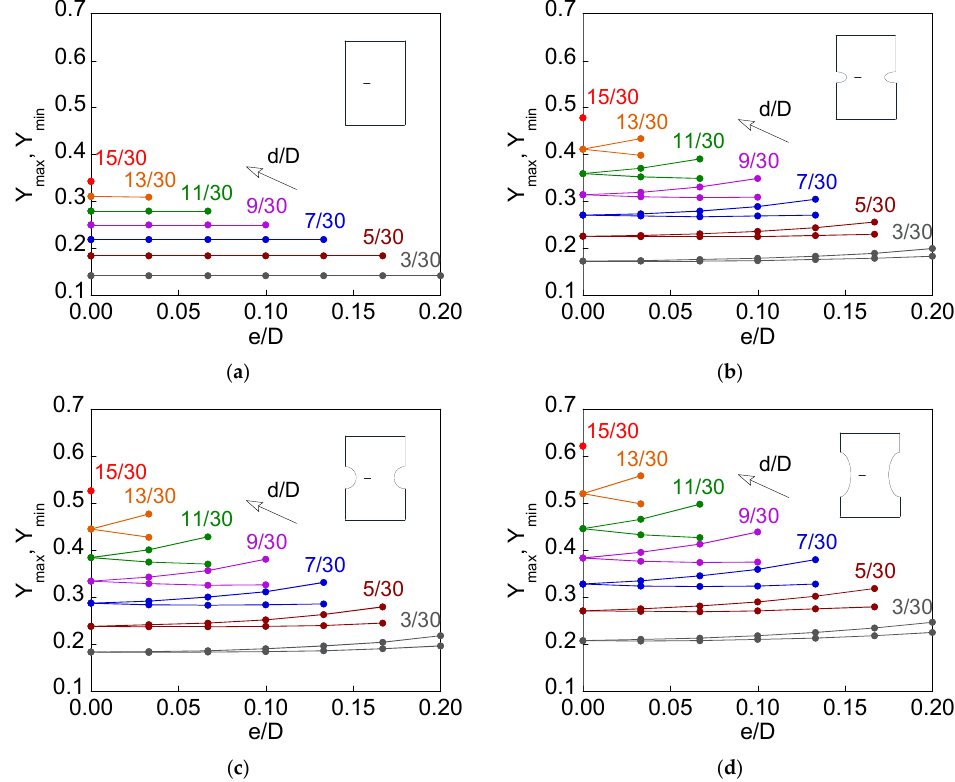
Figure 13. Maximum and minimum dimensionless FIT vs. relative crack eccentricity for several relative crack diameters: ( a ) smooth bar; ( b ) sharp notched bar; ( c ) circular notched bar; ( d ) blunt notched bar.